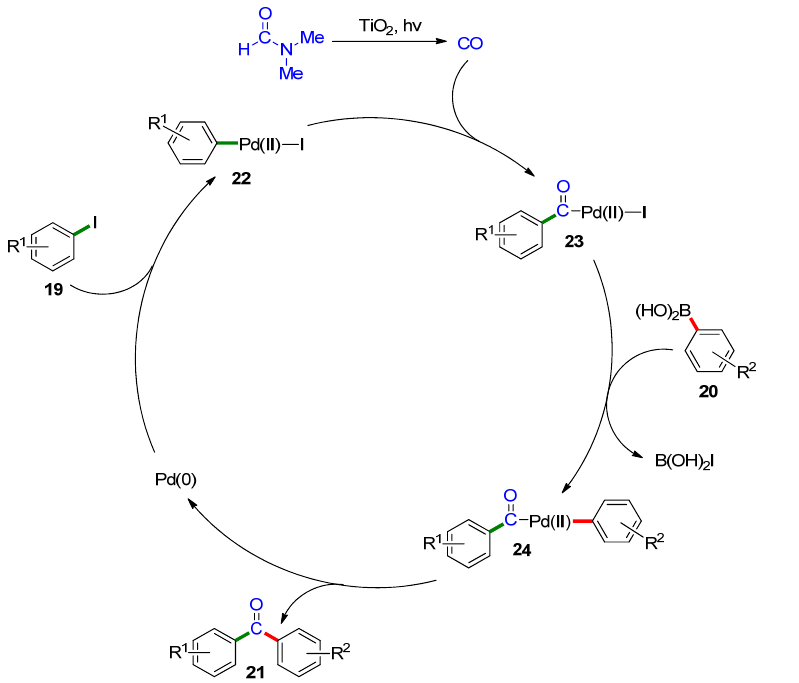
Scheme 9. Simplified proposed reaction mechanism for the Pd-catalyzed photocatalytic carbonyla- tive Suzuki–Miyaura coupling of aryl iodides 19 with aryl boronic acids 20 , reported in 2017 by Li